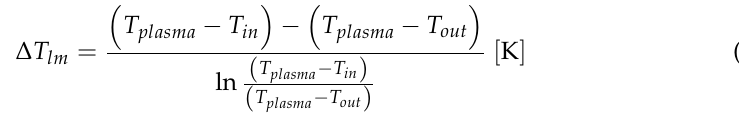
Figure 2. Generalized heat exchanger temperature profile.